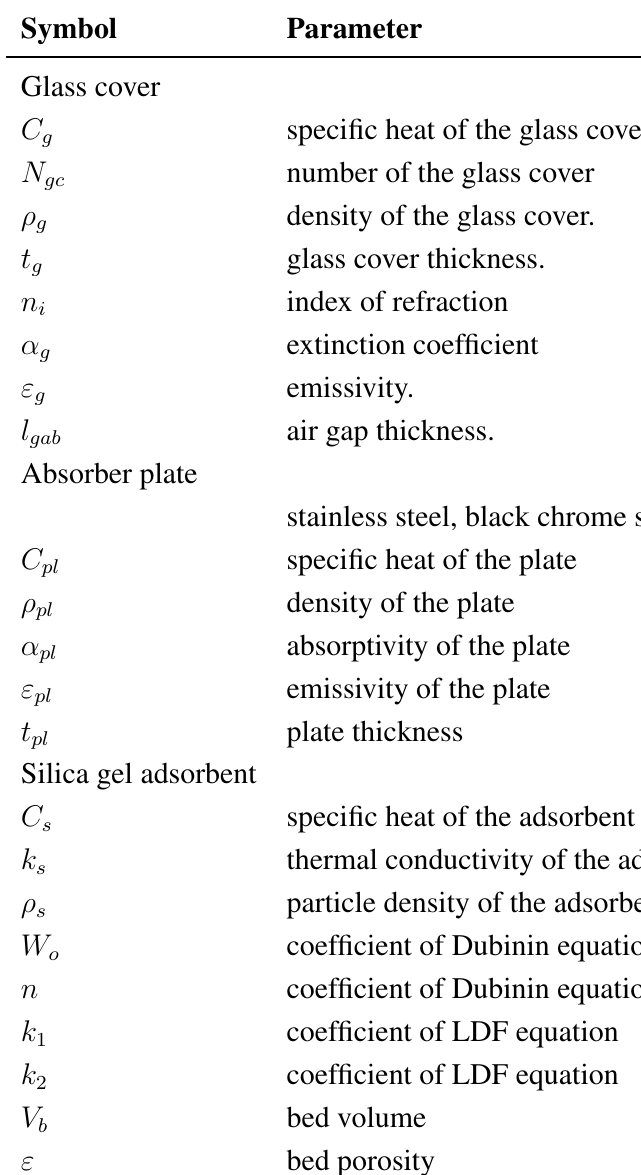
Table 1. The main parameters used in the case